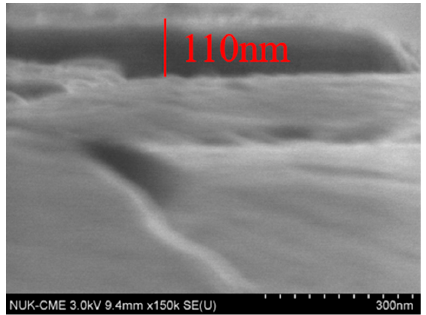
Figure 6. SEM cross-sectional image of SPAN deposited on a mild steel substrate with an AN/DABSA ratio of 8.8 swept fifteen cycles using cyclic voltammetry.